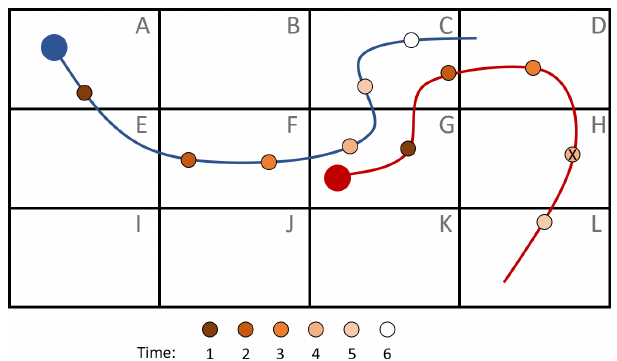
Figure 2. Two example trajectories on a binned fluid domain, with alphabet A, ... , L and τ = 7. The markers along the trajectories represent the points in time the location is stored. The itinerary for the blue particle is AAFFGCC. The red particle has itinerary GGCD_L_. Here, “_” denotes a missing data point, the one at time t = 4, indicated by an “X” in the respective marker. The last data point of the red trajectory is also missing, as its lifetime is shorter than τ time